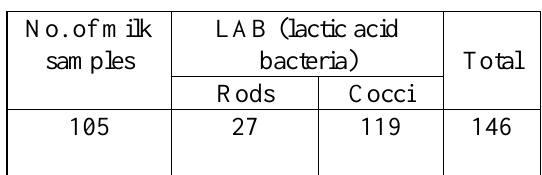
Table 1: Bacteriological isolates from milk samples